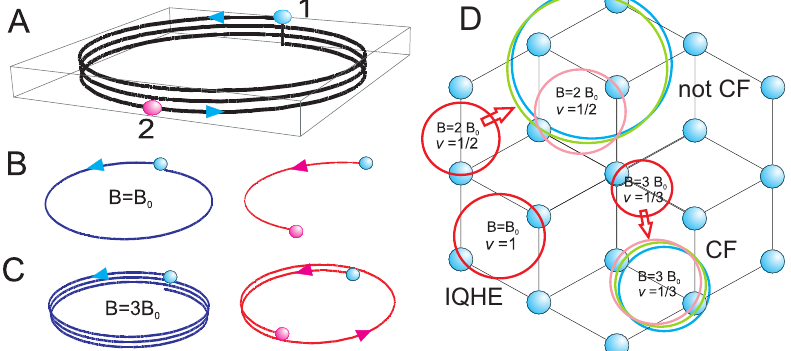
Figure 1. ( A ) An illustration of the commensurability of the three-loop cyclotron orbit with the separation of two closest particles, shown as blue and red. ( B ) An illustration of single-loop cyclotron orbit (left) and related braid for exchange of two closest particles, shown as blue one red—the braid is built from the half of the cyclotron orbit. ( C ) An illustration of thee-loop cyclotron orbit (left) and related braid for the exchange of two particles blue and red—in this case, the braid gains one additional loop (the third dimension added for clarity of the vision, more detail in Ref. [5]). ( D ) An illustration of the commensurability in Wigner-type lattice of electrons in graphene monolayer. Several situations are illustrated. The single-loop cyclotron orbit commensurability with nearest neighbors corresponding to IQHE at field B 0 . At three-times larger field 3 B 0 the single-loop orbit is too short to match nearest neighbors in the Wigner lattice—but the three-loop orbit fits to nearest neighbors. This corresponds to FQHE at ν = 1 . For field 2 B 0 single-loop orbit is also too short in comparison to the electron separation. 3 In this case the homotopy pattern with x 1 = 1, x 2 = 2, x 3 = 2 (cf. Table 2) allows fulfillment of the commensurability condition but for next-nearest neighbors for two loops—hence, this state is of FQHE type at ν = 1 , but not accessible for the CF model. The envelope function of multiparticle states in 2 graphene is distinct than the envelope function in GaAs. In graphene this envelope function favors next-nearest neighbor correlations, which manifest itself in stability in graphene of FQHE at ν = 1 beyond the CF model [47,55]. Table 2. Some selected homotopy patterns according to Equation (6) and the corresponding filling rates ν , x i calculated according Equation